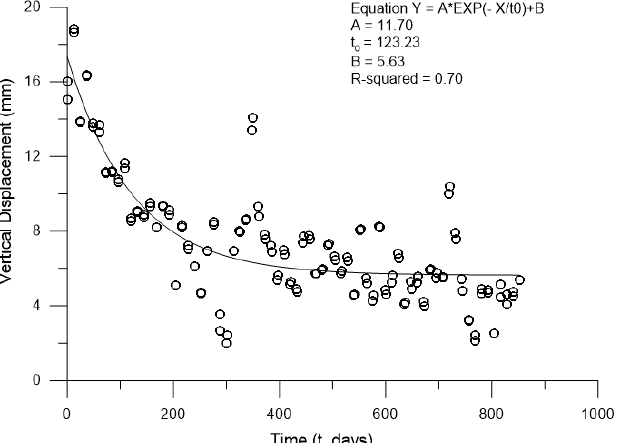
Figure 3. Post-seismic displacement at couple 25-6, along with the theoretical exponential curve e − t/ τ vs computed for relaxation time τ vs = 123 days (t indicates the time from the earthquake). East of the fault area—where both surface break and post-seismic deformation are revealed by the differential vertical displacement—some of the time series (20-11, 19-12, 18-13) individuate a section where relative subsidence of the southern block occurred during the 3 months preceding the earthquake, with a faster rate than the general trend, while no post-seismic subsidence was detected (Figure 2). The short sector (21-10) enclosed between these two fault segments exhibited both pre-seismic and post-seismic deformation, but no coseismic surface break.